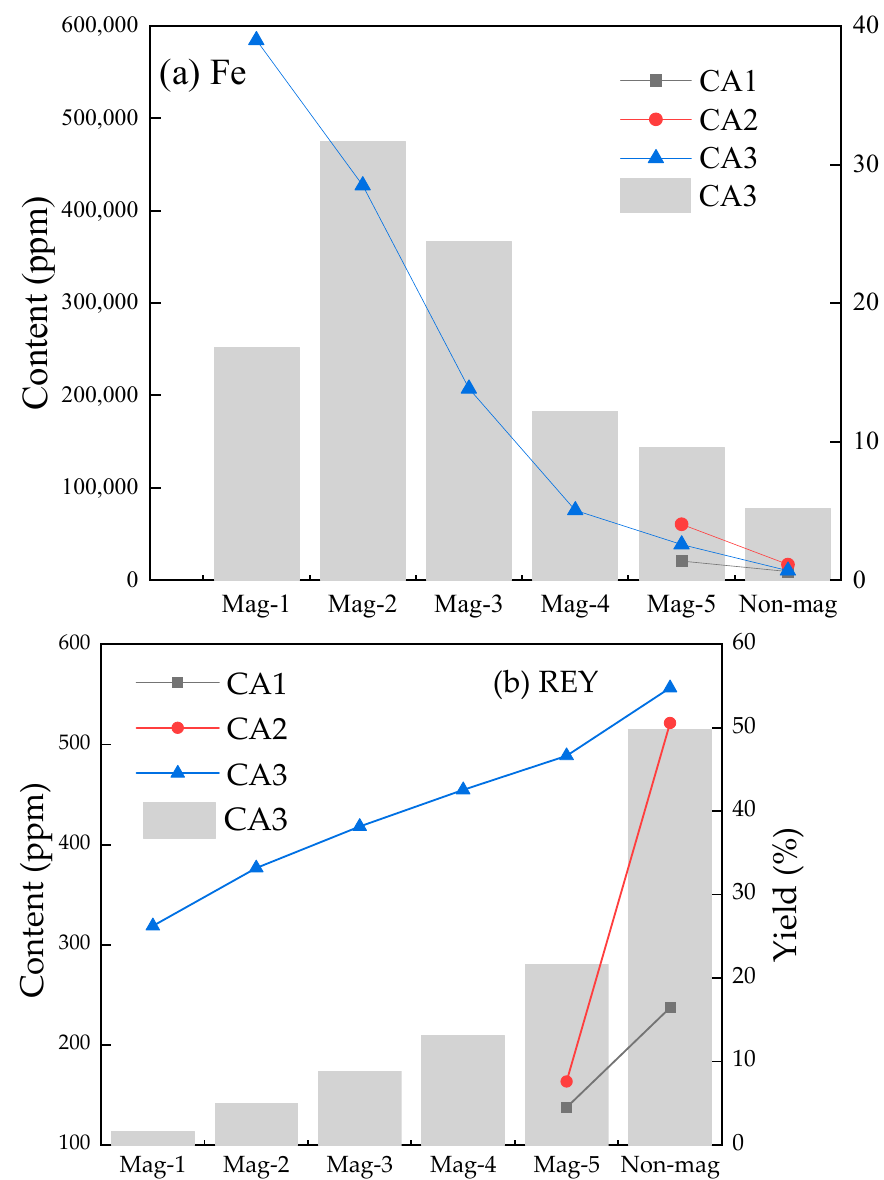
Figure 4. The contents and distribution of iron and REY in three coal ash samples.